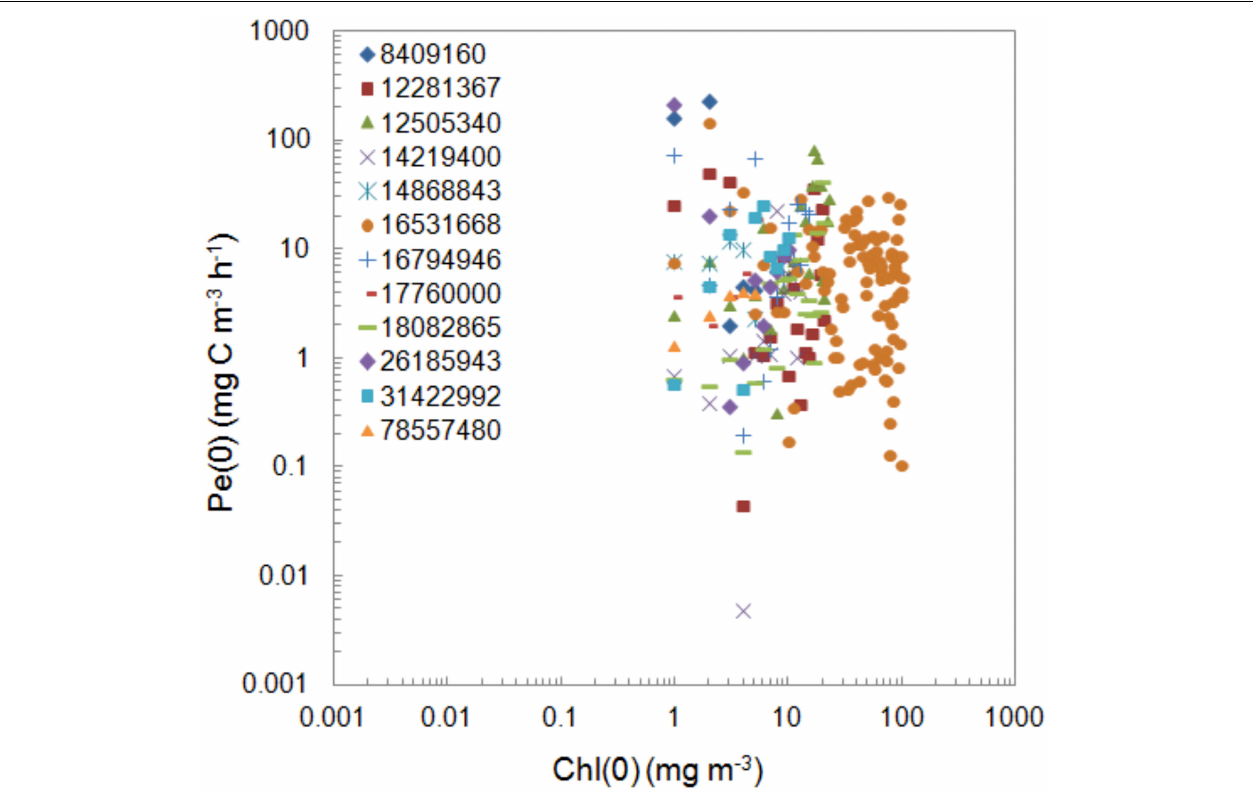
FIGURE 3 | Comparison of the values of the surface PP, Pe(0) determined within 1993–2018 period using isotope with different activity with respect to chlorophyll a concentration, Chl(0). The isotope activities expressed in dpm were shown as numbers and colored icons in